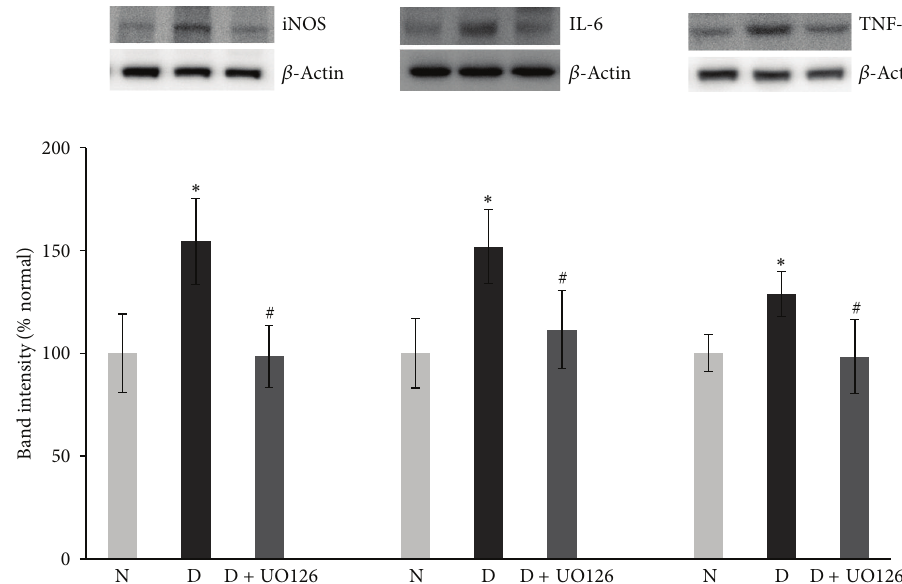
Figure 3: Effect of ERK 1/2 inhibitor (U0126) on diabetes induced iNOS, IL-6, and TNF- 𝛼 upregulation in diabetic retina. (a) Protein expression of iNOS, (b) IL-6, and (c) TNF- 𝛼 was measured by western blot and 𝛽 -actin was used as housekeeping control. Each measurement was performed at least three times. Results are expressed as mean ± s.d. of at least six rats in each group. ∗ 𝑃 < 0.05 compared with normal rats and # 𝑃 < 0.05 compared to diabetic rats. N, D, and D + U0126 = normal, 1 week diabetic and U0126 pretreated diabetic